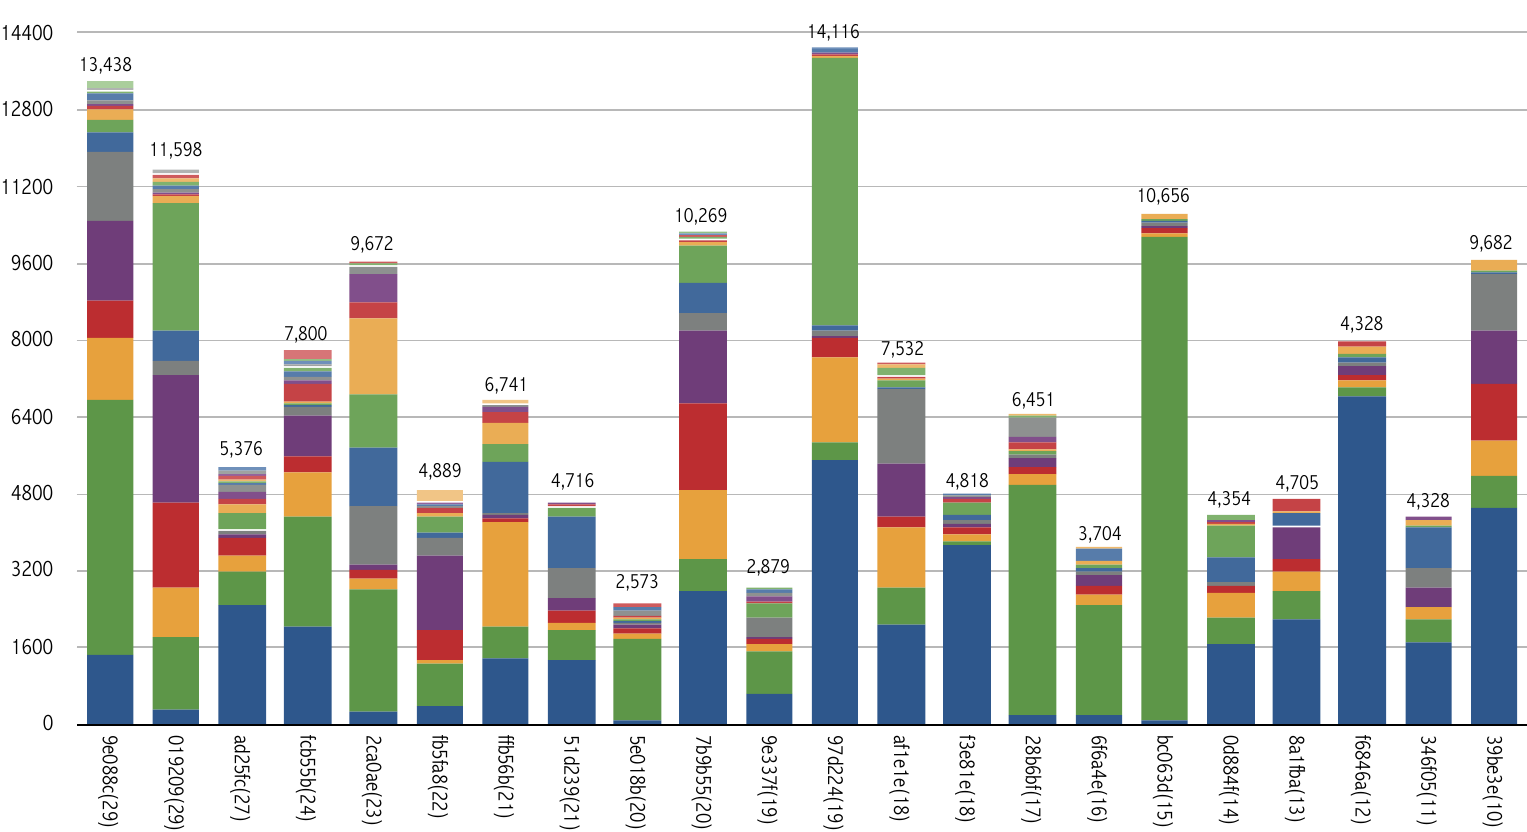
Figure 12. Performers with the number of transferring works to themselves (10 or more different involved